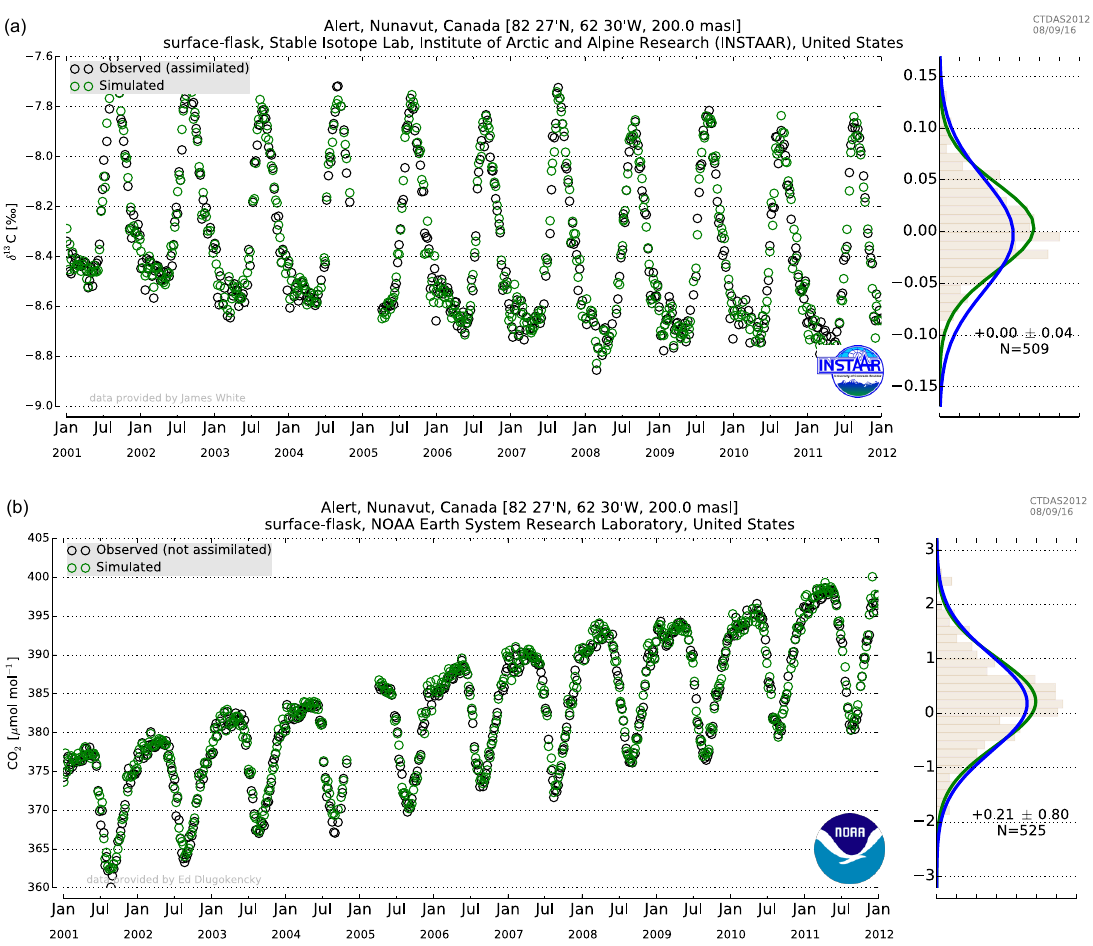
Figure 8. Comparison of two different inversion experiments at Alert (ALT, Canada). The top panel displays δ 13 C observations (black circles) together with simulated δ 13 C from NEW − CO2C13 (green circles). The top right panel displays the probability density functions (PDFs) of the residuals between NEW − CO2C13 and observed (green) and between TRAD − CO2 and observed (blue). The lower panel displays independent flask measurements (not used in the assimilation) of CO 2 (black circles) at Alert with simulated CO 2 from NEW − CO2C13 (green circles). Notice the almost identical distribution of the residual PDFs between NEW − CO2C13 and TRAD − CO2 inversion